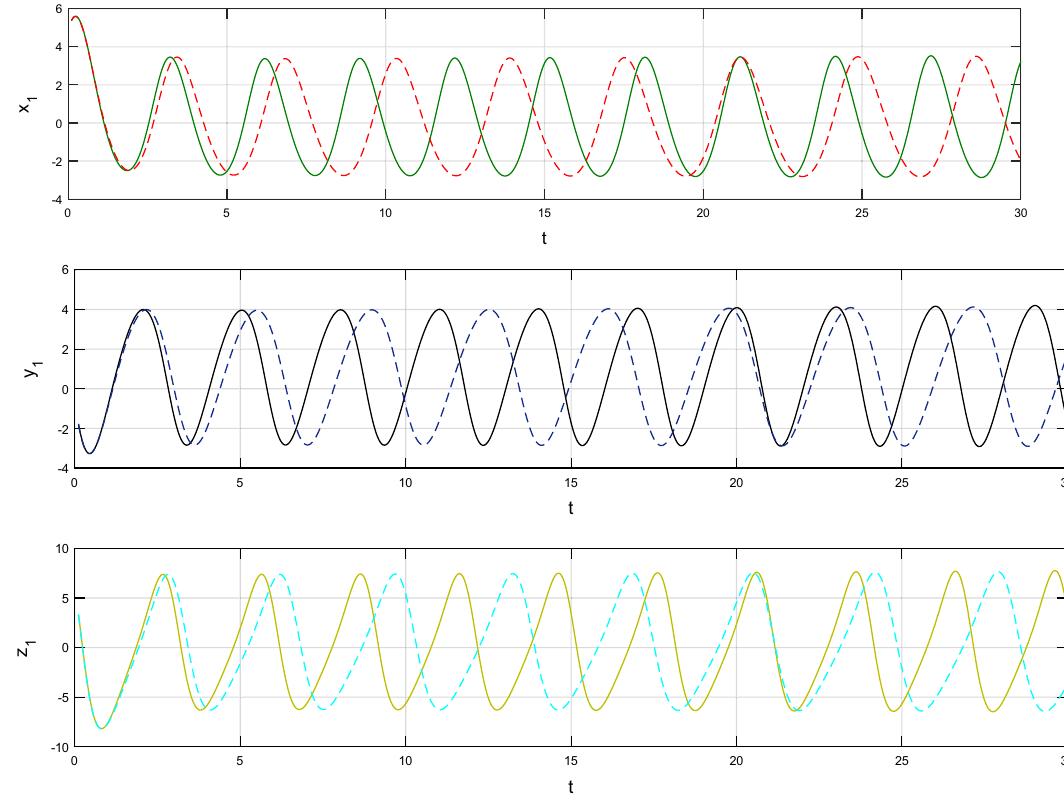
Figure 9. An analysis of the chaotic attractors for this case when β = 1 (line) and β = 0.95